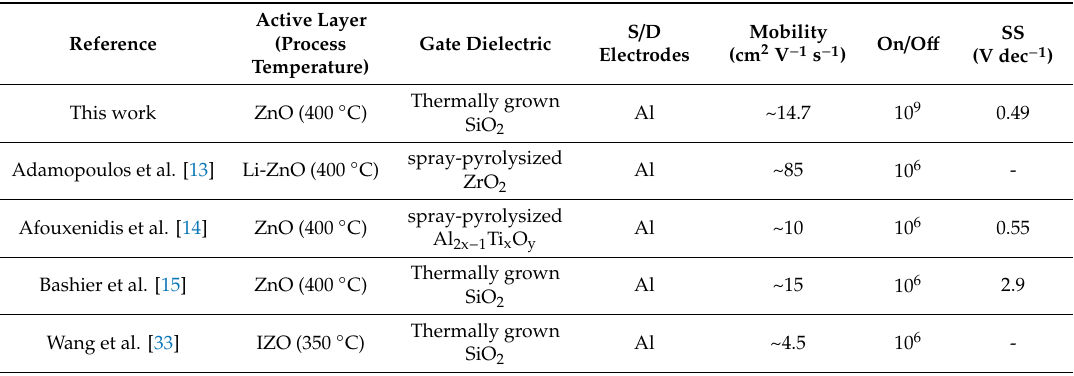
Table 1. Comparisons of the electrical characteristics of previously reported metal-oxide FETs by spray pyrolysis